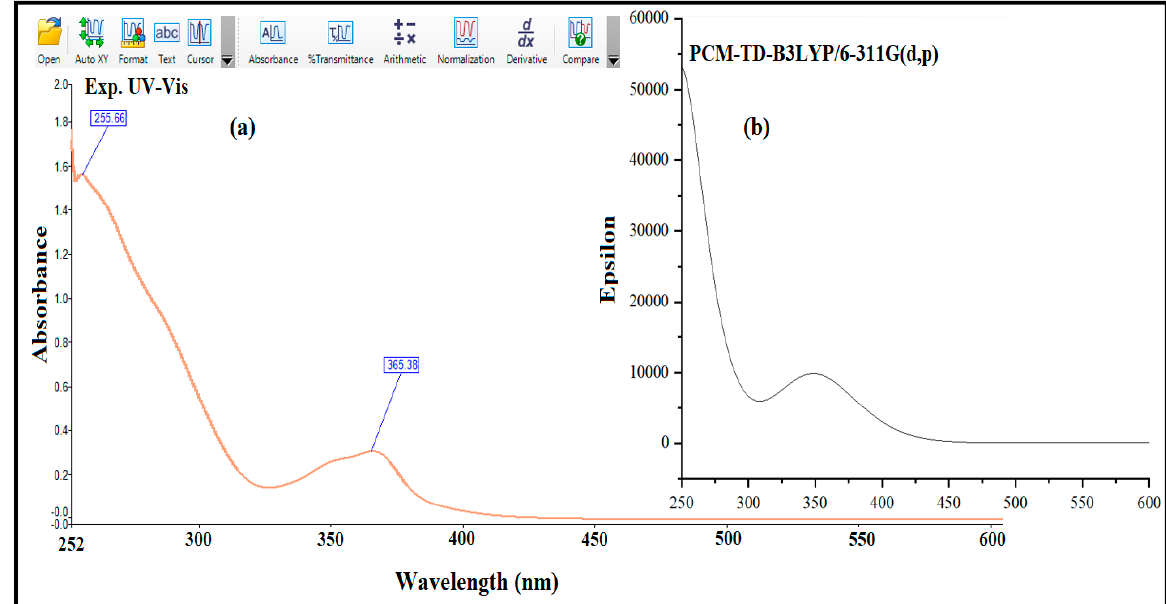
Figure 7. Experimental ( a ) and calculated ( b ) UV-vis absorption spectra of the 4,6-Diacetylresorcinol.